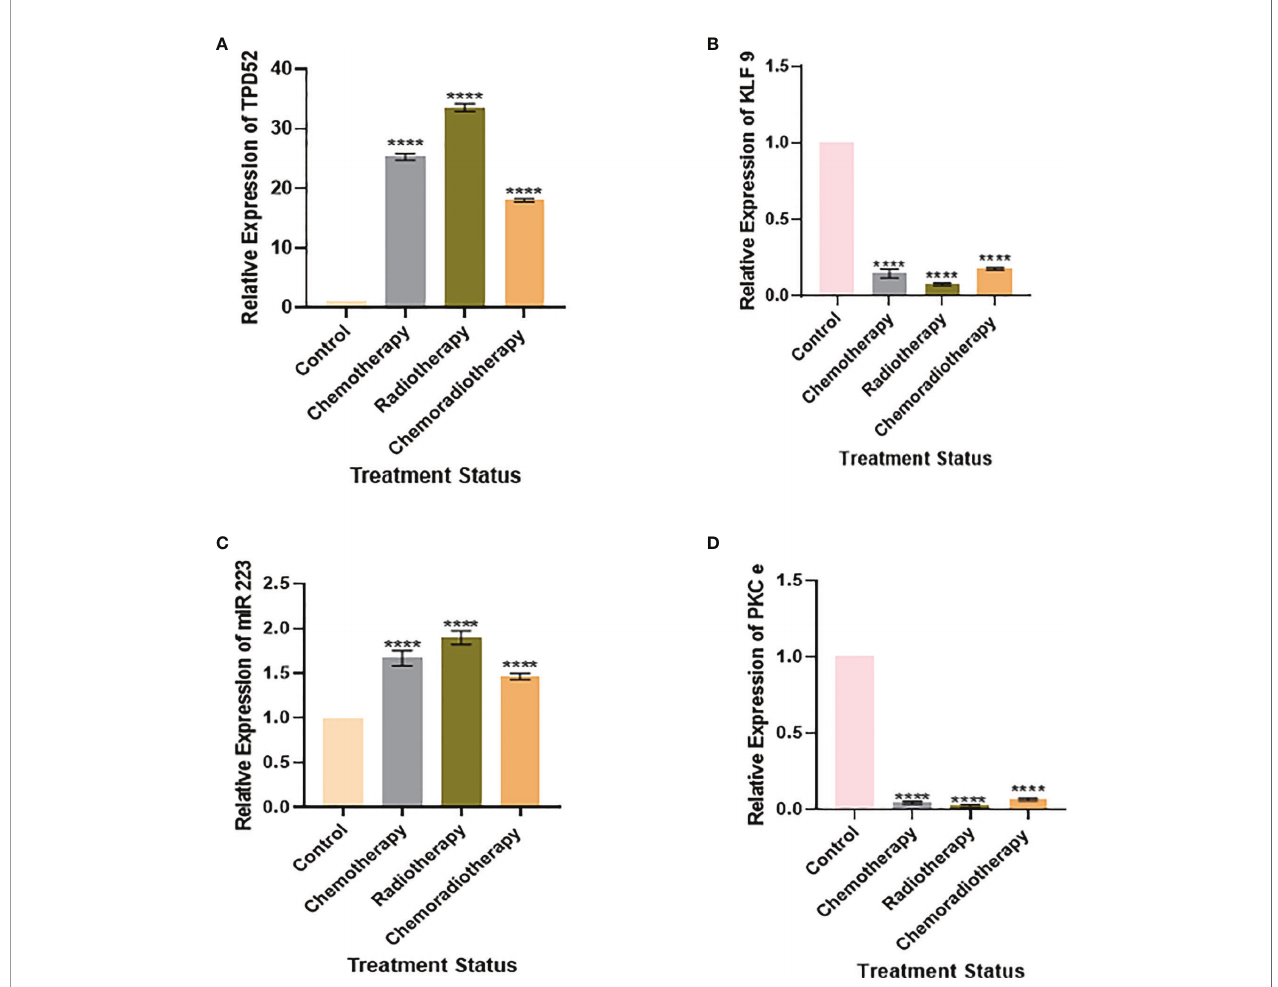
FIGURE 8 | Relative gene expression with treatment status. (A) Relative TPD52 expression. (B) Relative KLF9 expression. (C) Relative miR-223 expression. (D) Relative PKC ϵ expression. Illustrative data are presented as the mean ± SEM of triplicate experimentations. Fold change is plotted on the y -axis and study groups on the x -axis. Statistical signi fi cance was measured by ordinary one-way ANOVA (**** p <